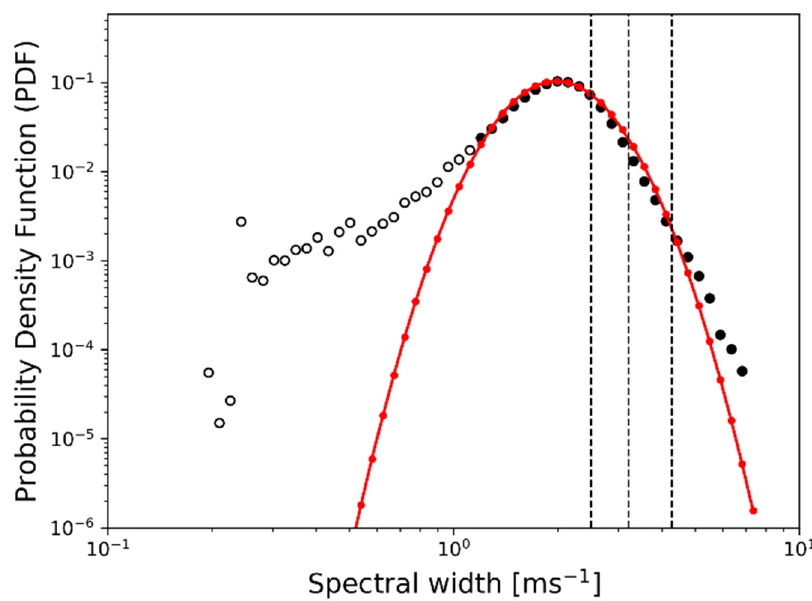
Figure 7. Histograms (circles) of the observed radar SW data below z = 8 km from 04:50 to 05:50 UTC on 28 October 2018 and the best lognormal probability density function (PDF) fit (red curve) in the log-log domain. Filled circles indicate the data used for constructing the best PDF fit, while open circles are excluded for calculating the best fit. The vertical black dashed lines represent the thresholds of the SW for the LGT, MOD, and SEV turbulence (left to right), corresponding to EDR values of 0.15, 0.22, and 0.34 m 2/3 s -1 , respectively.